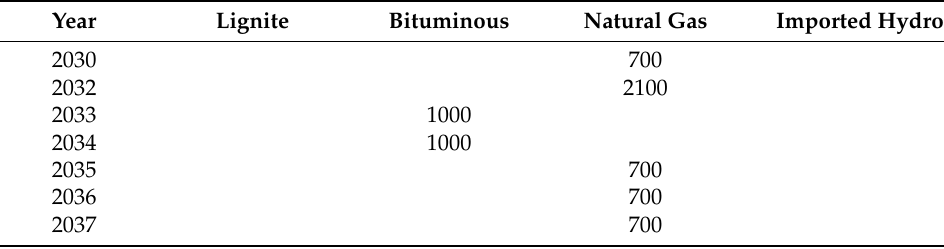
Table A7. Additional generation units (MW).